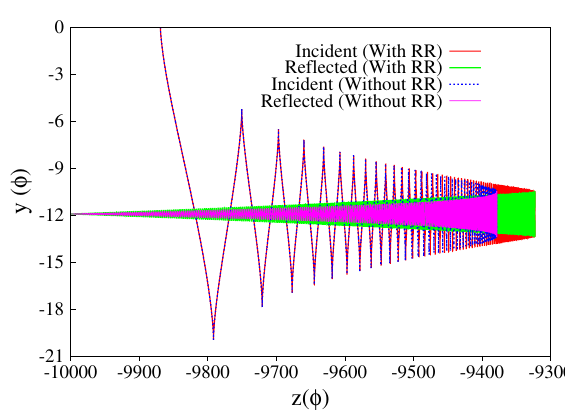
Figure 6. Figure represents the trajectory of the charged particle. The blue and magenta curves represent the forward and reflected motion of the particle in the absence of radiation reaction effects, whereas red and green curves respectively represent the forward and reflected motion of the charged particle in the presence of radiation reaction